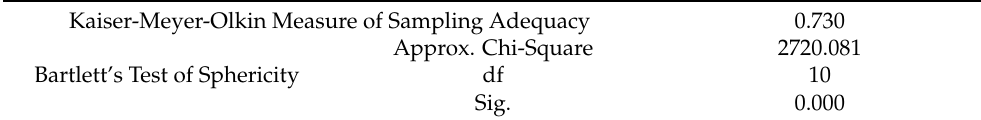
Table 1. KMO and Bartlett’s